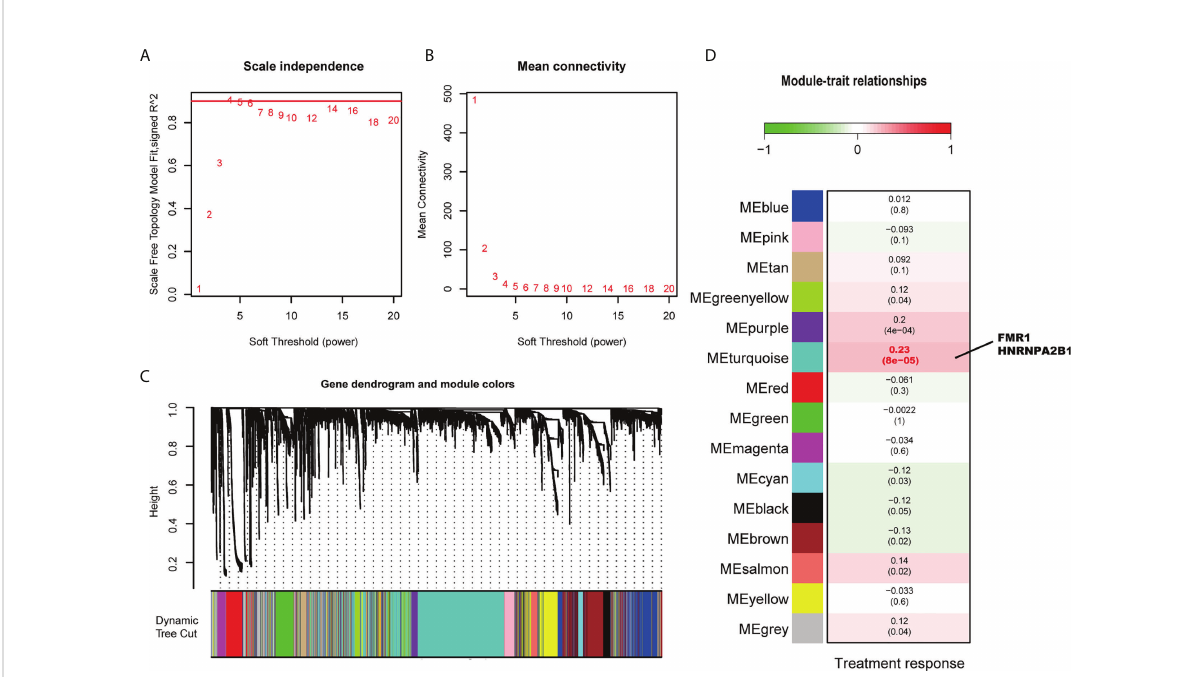
FIGURE 3 Weight Gene Co-expression Network Analysis. (A) Analysis of the scale-free index for various soft power thresholds. (B) Analysis of the mean connectivity of various soft power thresholds. (C) Dendrogram of the genes clustered based on a dissimilarity measure (1-TOM). (D) Average gene signi fi cances and errors in the modules associated with treatment response. The turquoise module was the most signi fi cantly correlated to treatment response. FMR1 and HNRNPA2B1 are in this